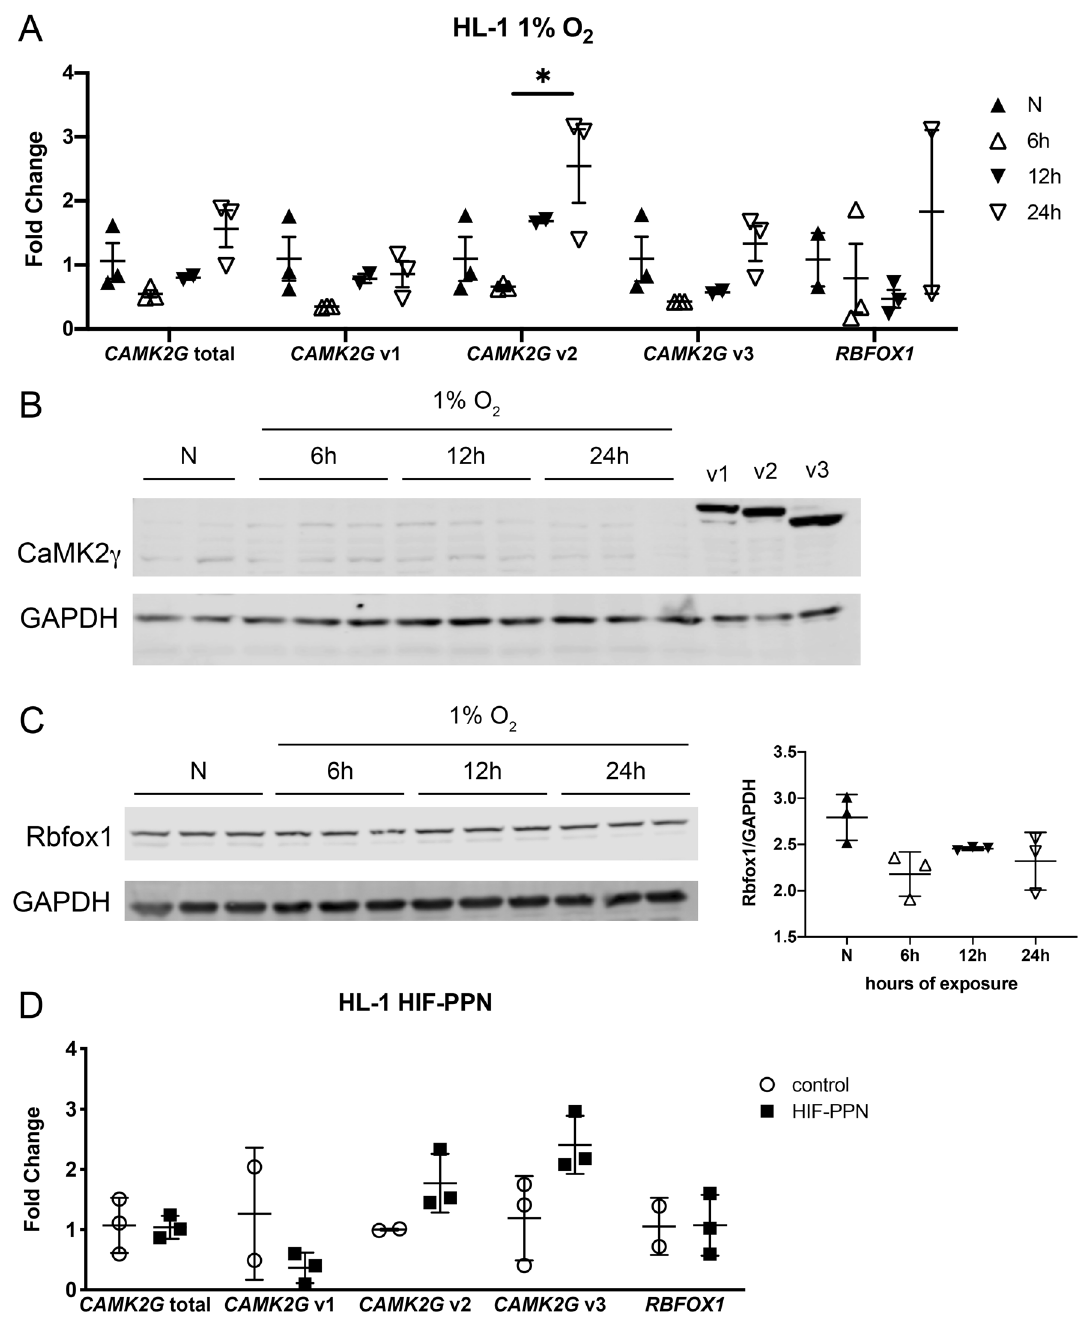
Figure 6. CAMK2G splicing with HIF-PPN or hypoxia in vitro. ( A ) rt-PCR data for RBFOX1 and CAMK2G splice variant expression in HL-1 cells exposed to 1% O 2 . Fold change compared to normoxia, n = 2–3 per condition. Overall p -values for total CAMK2G , CAMK2G v1, CAMK2G v2, CAMK2G v3 and RBFOX1 were p = 0.06, p = 0.19, p = 0.04, p = 0.10 and p = p = 0.51, respectively, using one-way ANOVA with Tukey’s multiple comparisons. * p < 0.05 for between group comparisons. ( B , C ) Western blots for CaMK2γ ( B ) and Rbfox1 ( C ) for HL-1 cells exposed to 1% O 2 . Cropped blots shown, with GAPDH used for loading control and normalization. Recombinant proteins for each CaMK2γ variant were used for comparison. n = 2–3 per condition. For panel D, quantification graph shown to the right. Using one-way ANOVA with Tukey’s multiple comparisons, overall p -value = 0.06. Uncropped western blots shown in Supplementary Fig. 4. Data representative of at least 3 independent experiments. ( D ) rt-PCR data for RBFOX1 and CAMK2G splice variant expression in HL-1 cells transfected with HIF-PPN. Fold change compared to control, n = 2–3 per group. Using student’s t test, p = 0.91, p = 0.24, p = 0.12, p = 0.07 and p = 0.97 for total CAMK2G , CAMK2G v1, CAMK2G v2, CAMK2G v3 and RBFOX1 ,